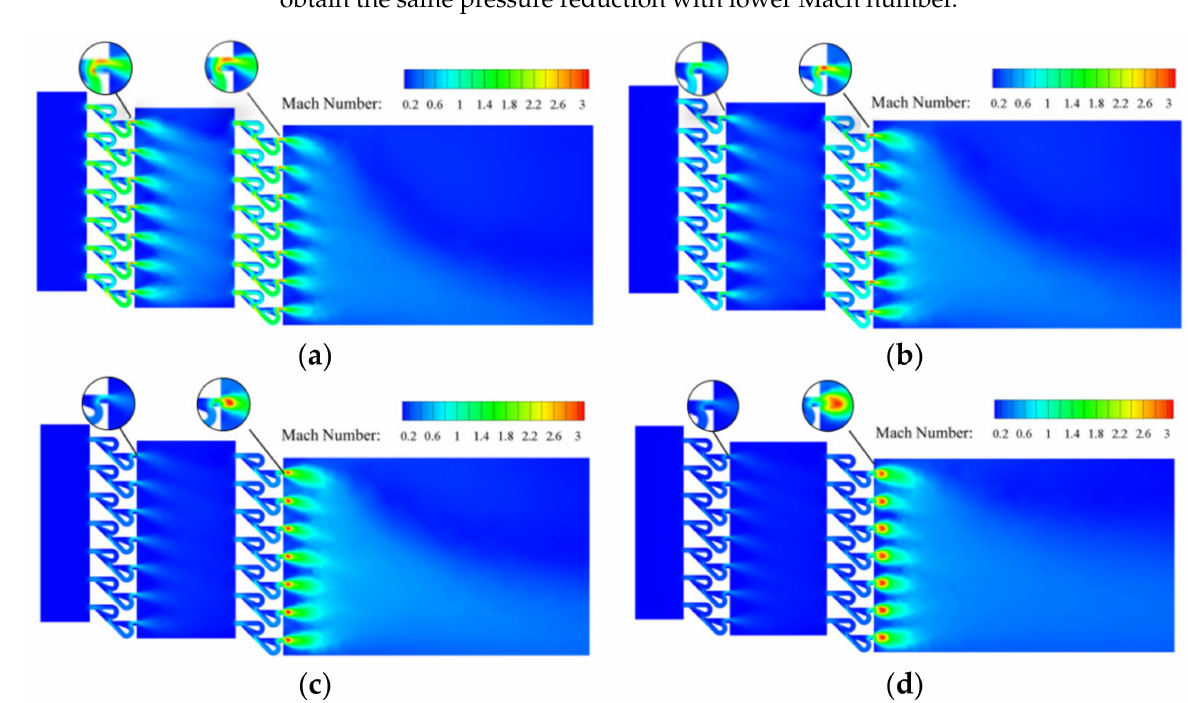
Figure 15. Mach number distribution on the symmetry plane for the two-stage Tesla-type orifice struc- ture under different mass flow rates. ( a ) Q m = 0.02 kg s − 1 . ( b ) Q m = 0.1 kg s − 1 . ( c ) Q m = 0.5 kg s − 1 . ( d ) Q m = 1 kg s − 1